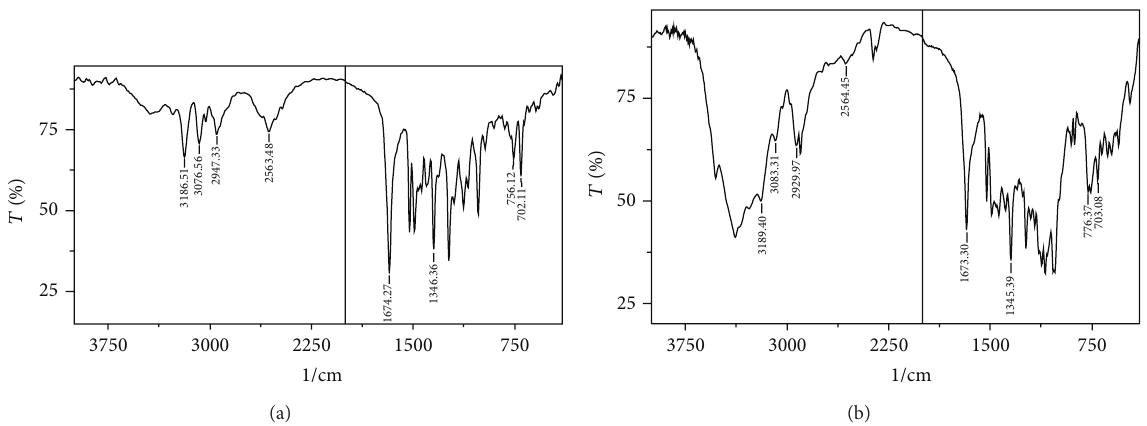
Figure 4: FTIR spectra of (a) lercanidipine HCl and (b) optimized tablet, FP 14. 1 h 0 h